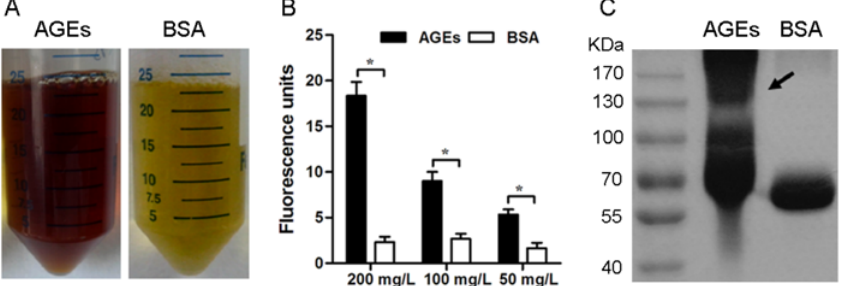
Figure 1. Characterization of the AGEs prepared in the current study. ( A ) Representative photos of AGEs and BSA. ( B ) Histogram represents the obvious increase in fluorescence intensity emitted from AGEs. Results are expressed as mean ± SD, n = 3, * p < 0.05. ( C ) Representative SDS-PAGE graphs of AGEs and